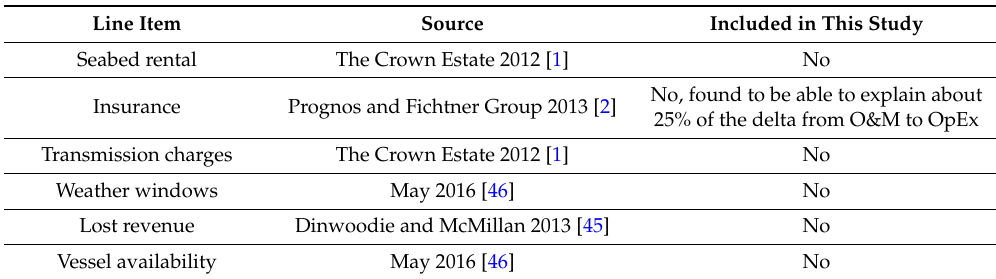
Table 6. Missing line items in most detailed levelized cost of energy related cost